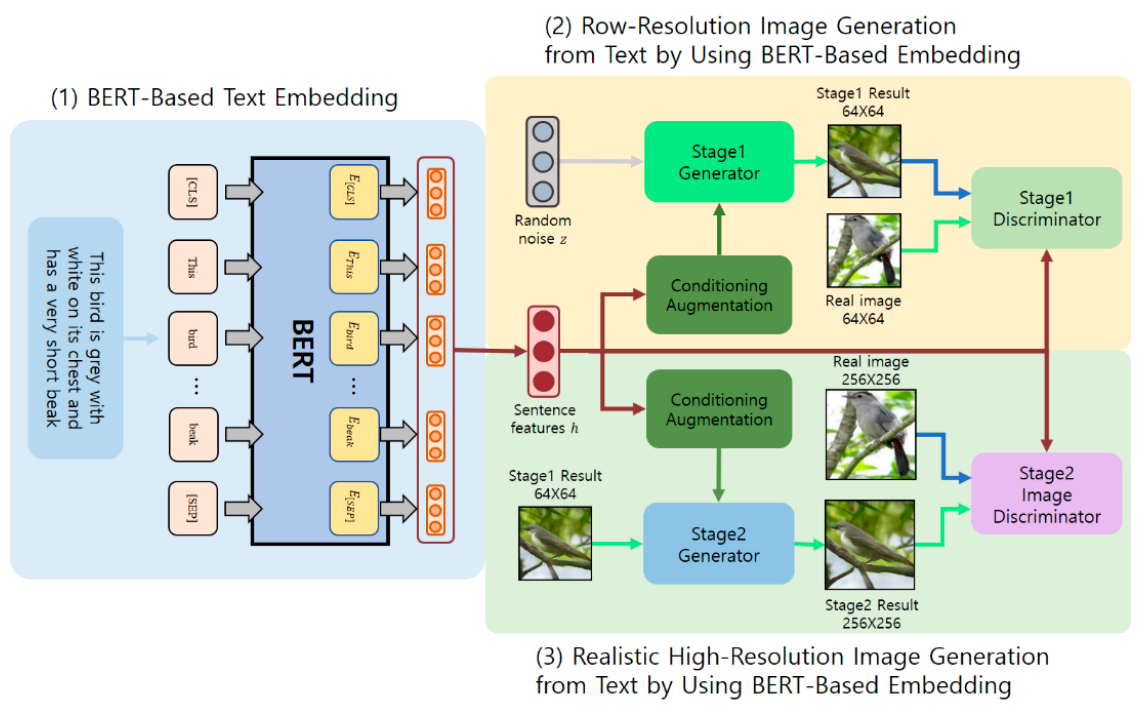
Figure 1. Generating realistic images from text using BERT-based embeddings.